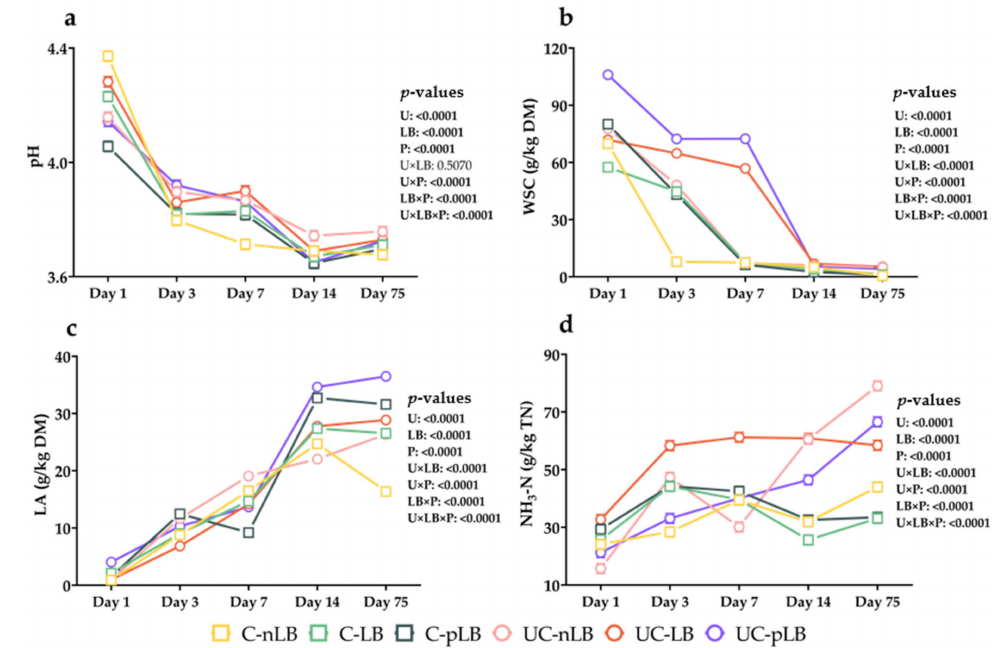
Figure 4. Effect of the ensiling length, the treatment with urea, and preactivation of L. buchneri on fermentation indices. Changes in pH ( a ), water-soluble carbohydrate [WSC, ( b )], lactic acid [LA, ( c )], and ammonia-nitrogen [NH 3 -N, ( d )] content of corn silage. C: corn silages not treated with urea, UC: corn silages treated with 1.0% urea on dry matter basis, C-nLB: corn silages not treated with urea and uninoculated with L. buchneri , C-LB: corn silages not treated with urea and inoculated with L. buchneri , C-pLB: corn silages not treated with urea and inoculated with preactivated L. buchneri , UC-nLB: corn silages treated with urea and uninoculated with L. buchneri , UC-LB: corn silages treated with urea and inoculated with L. buchneri , UC-pLB: corn silages treated with urea and inoculated with preactivated L. buchneri . Factors that are statistically significant are highlighted in bold ( p <